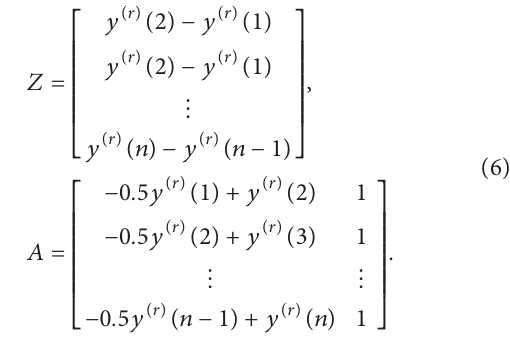
Figure 1: The construction principle of FGM(1,